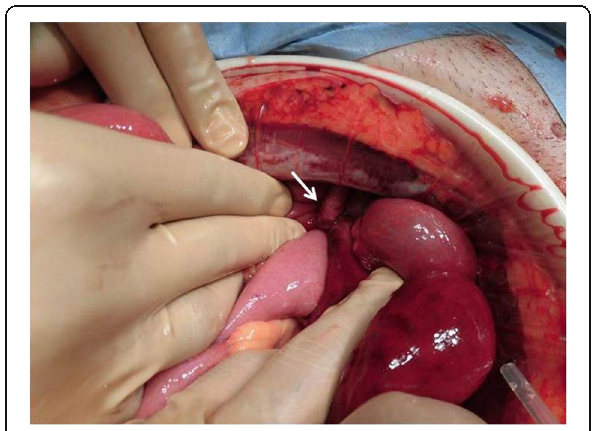
Fig. 2 Findings at laparotomy. The ileum, which was approximately 60 cm proximal to the ileocecal junction, formed a closed loop beneath the left external iliac artery